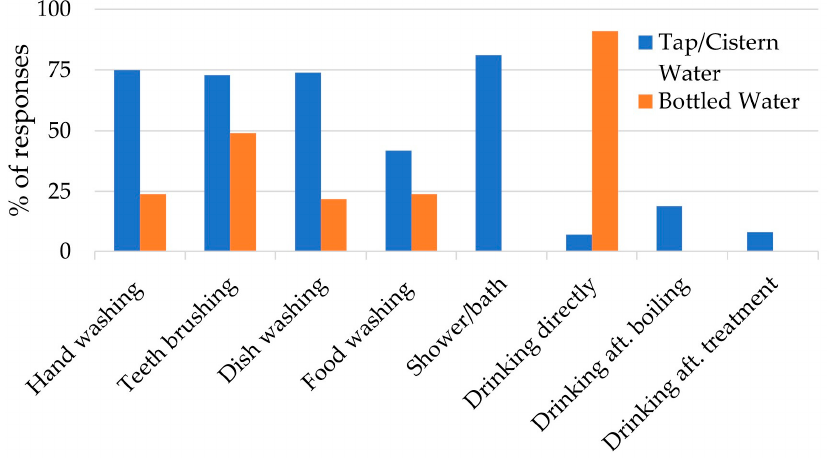
Figure 1. Survey responses (n = 107) of water usage in St. Thomas, Virgin Islands, after the hurricanes in 2017.